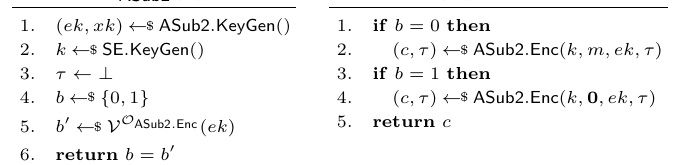
Figure 12: The IND-CPA 0 game for asymmetric ASA ASub2